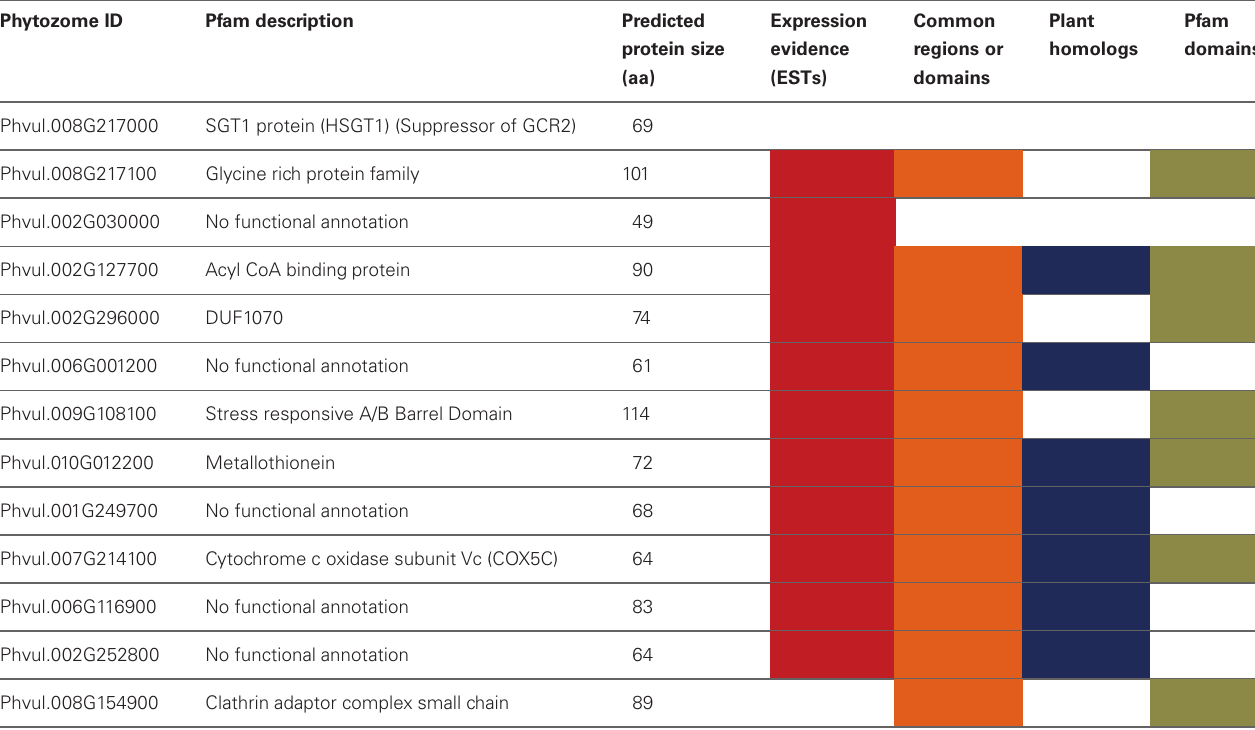
Table 7 | sORF expression during nodule ontogeny.